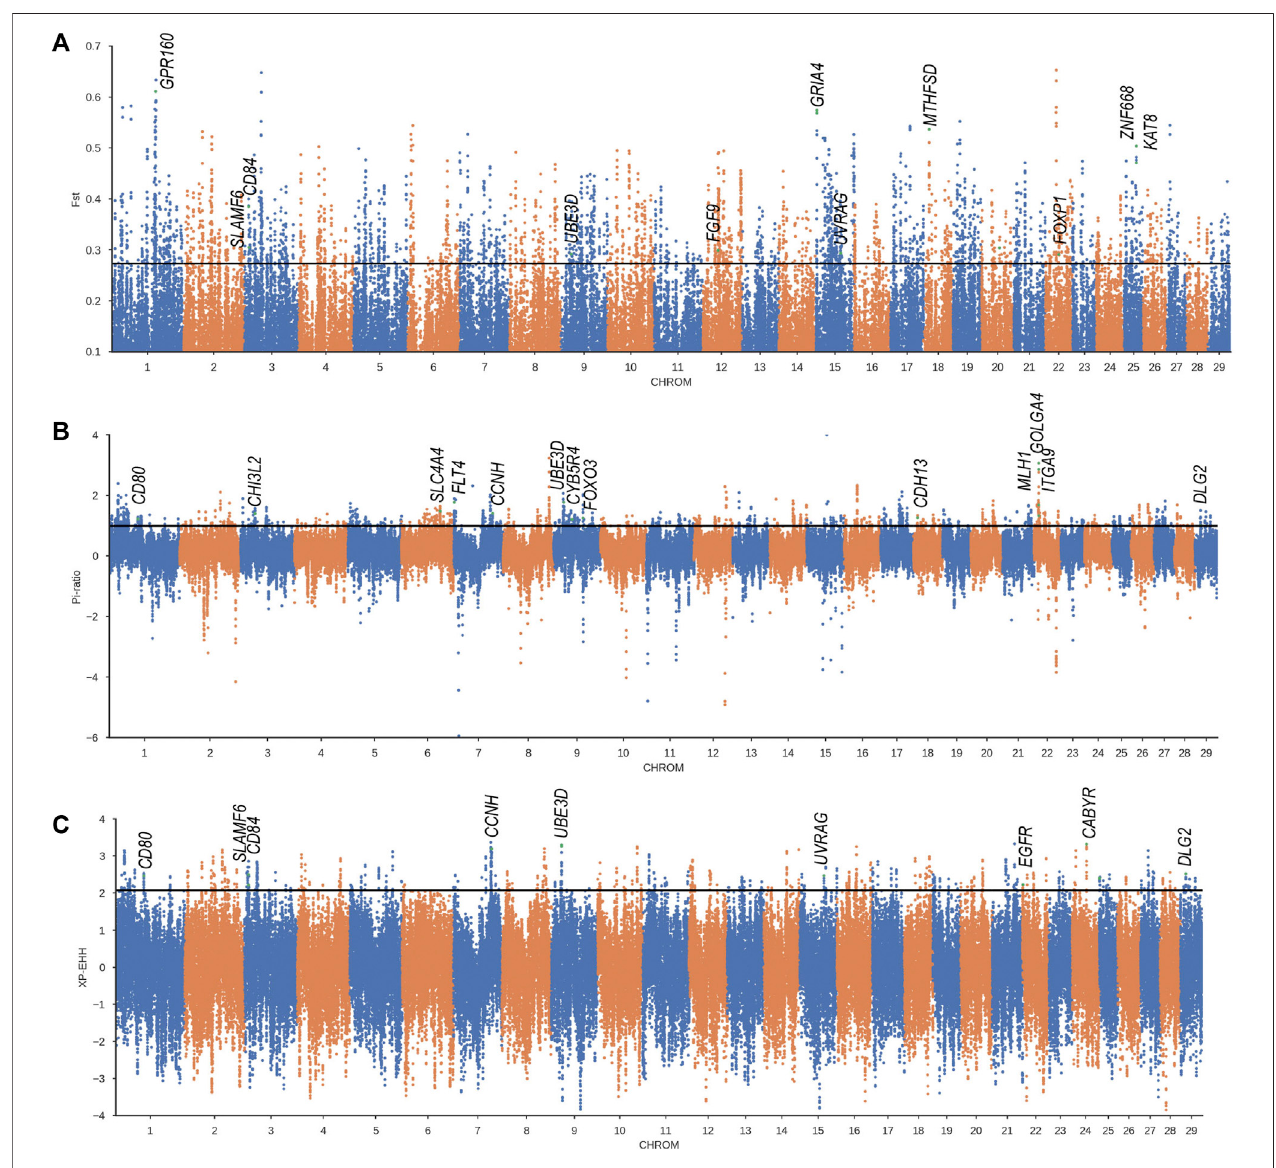
FIGURE3 | Genome-wide selection scanin Weining cattleusing sliding window analysis(50 kbwindow size, 20 kb stepsize,99thpercentilecutoff) (A) .Selection signatures in Weining cattle for F ST (Weining-to-Wenshan & Wannan). (B) . Selection signatures in Weining cattle for π -ratio (Wenshan & Wannan/Weining). (C) Selection signatures in Weining cattle for XP-EHH (Weining-to-Wenshan & Wannan). The threshold (top 1%) of F ST , π -ratio, and XP-EHH was marked with a horizontal black line.